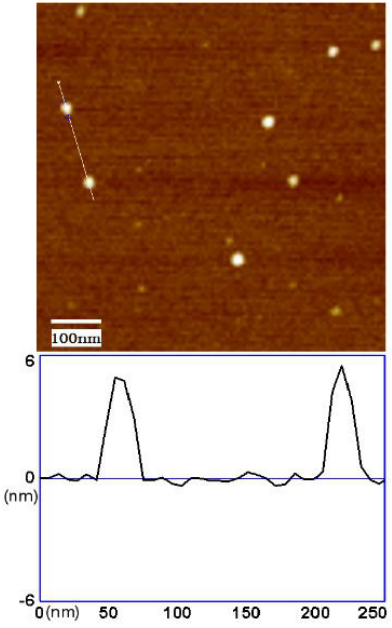
Figure 7. Structure of P(BPMA- co -ProHEMA) gel - b -PMMA on a silica wafer visualized by using AFM.